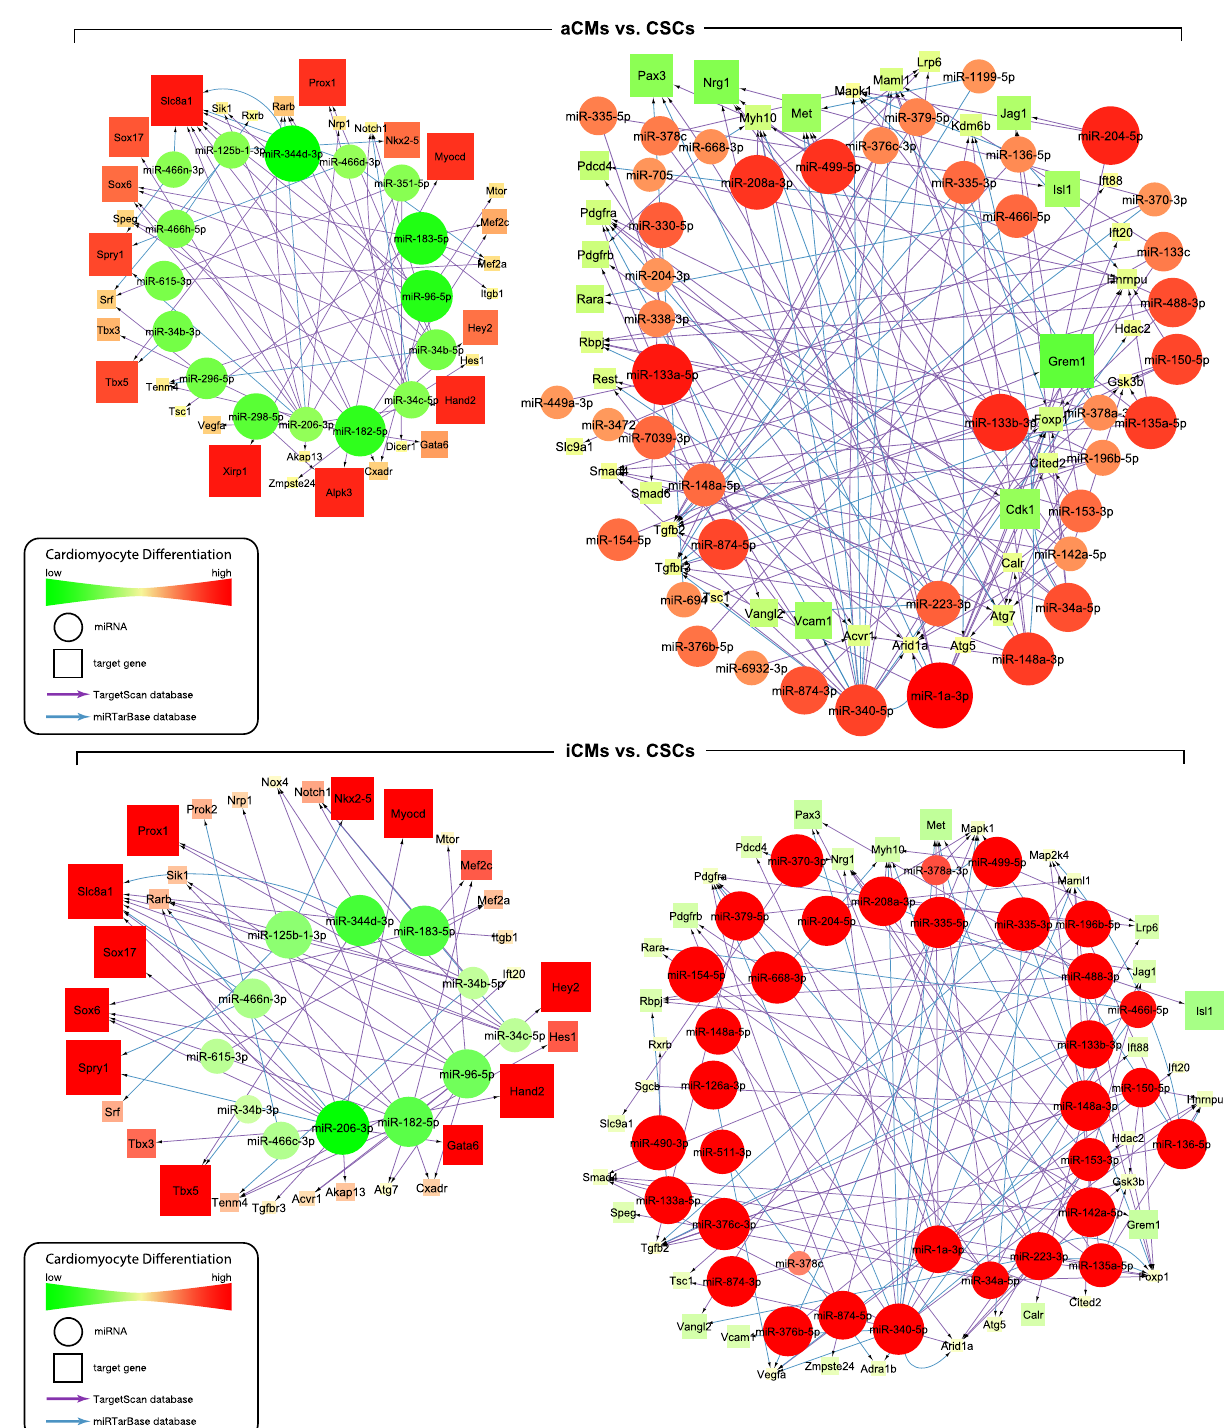
Fig. 5 miRNA/mRNA networks describing the process of cardiomyocyte differentiation. The networks were built starting from the down-regulated (left) and up-regulated (right) miRNAs in the “ iCMs vs. CSCs ” (upper panel) and “ aCMs vs. CSCs ” (bottom panel) comparisons, respectively. The networks were developed inserting each miRNA/mRNA target that was effectively up-regulated for the down-regulated miRNAs and each miRNA/mRNA target that was effectively down-regulated for the up-regulated miRs. Differentially expressed miRNAs were used as starting nodes to generate the interaction network of miRNAs and their targets. Each link connects the source (miRNA, circle) and its targets (mRNA, squares). The colors represent changes in expression (green as down-regulated, red as up-regulated). Subsequentially functional analysis of miRNA/mRNA networks was done for selected biological processes. All RNASeq data are representative of biological triplicates for CSCs and iCMs and of biological duplicate for aCMs. Each of the biological replicate was veri fi ed by a technical